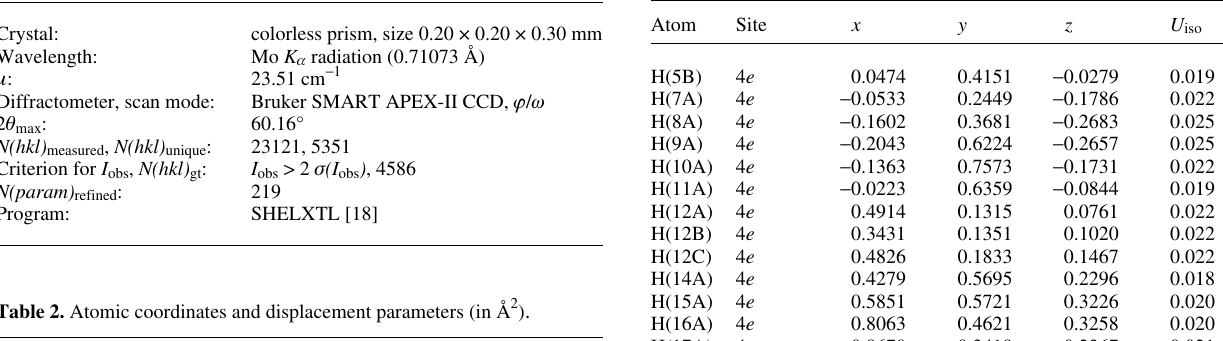
Table 1. Data collection and